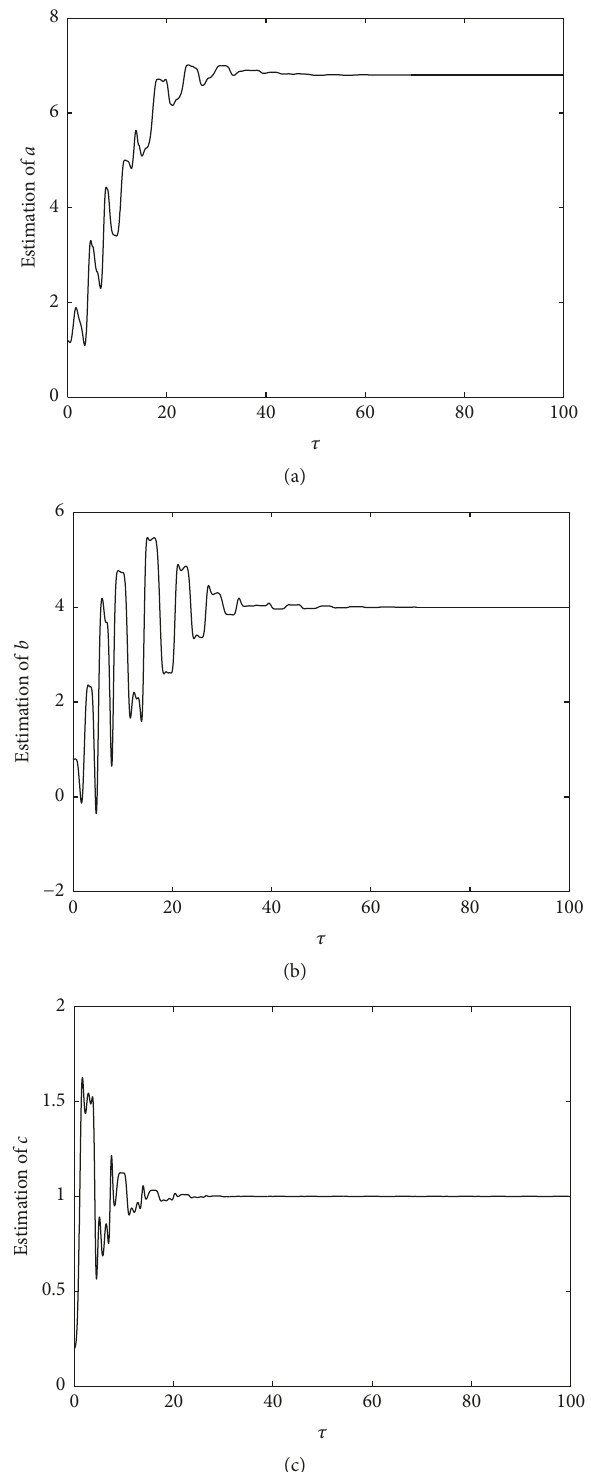
̂ 𝑏 , and (c) ̂𝑐 . The initial conditions are selected randomly